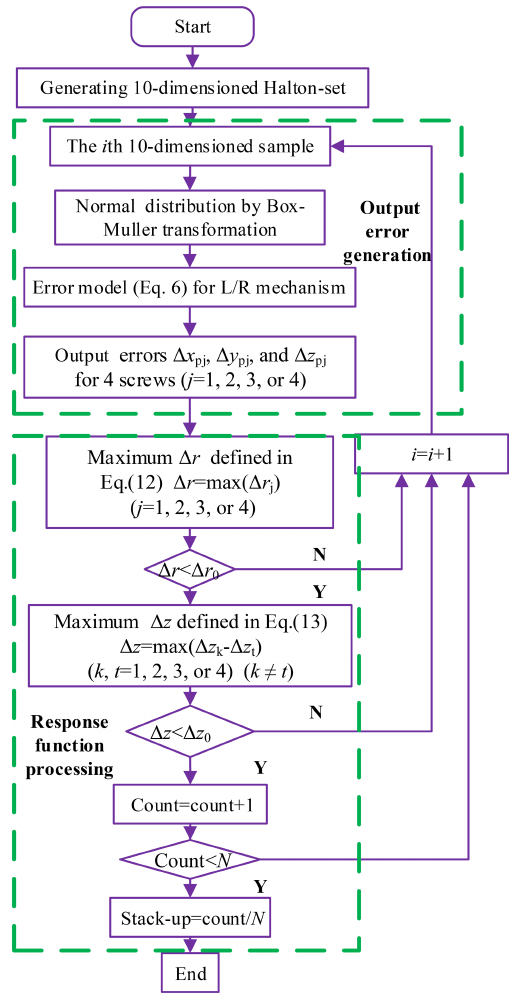
Figure 7. Scheme of Halton-set based simulation for the tolerance stack-up and for each column in the uniform DOE